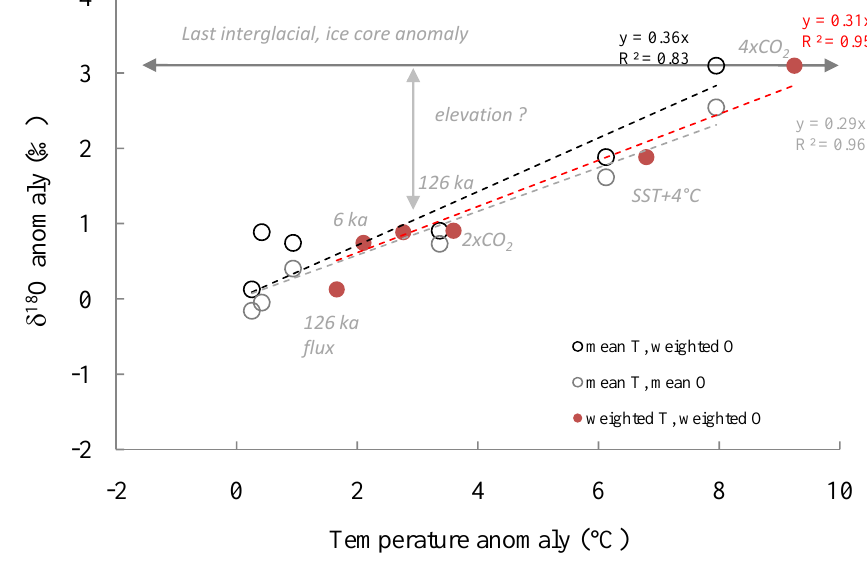
Fig. 7. Simulated anomalies of Greenland precipitation-weighted δ 18 O as a function of mean temperature (black open circles) and precipitation-weighted temperature (red filled circles). Simulated anomalies of Greenland annual mean δ 18 O as a function of annual mean temperature (grey open circles) are also displayed for all the LMDZiso simulations. Anomalies are calculated with respect to the AMIP control simulation. Linear regressions are also